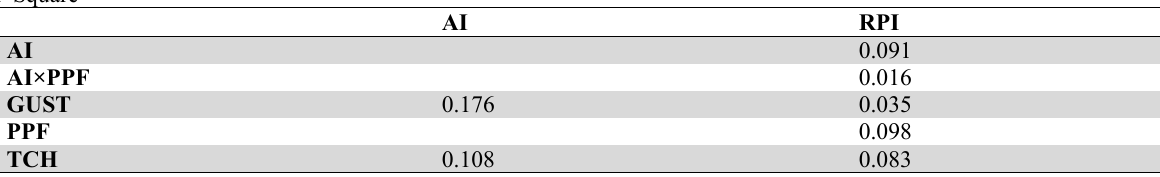
R Square Construct R Square Repurchase Intention 0.261 Airline Image 0.431